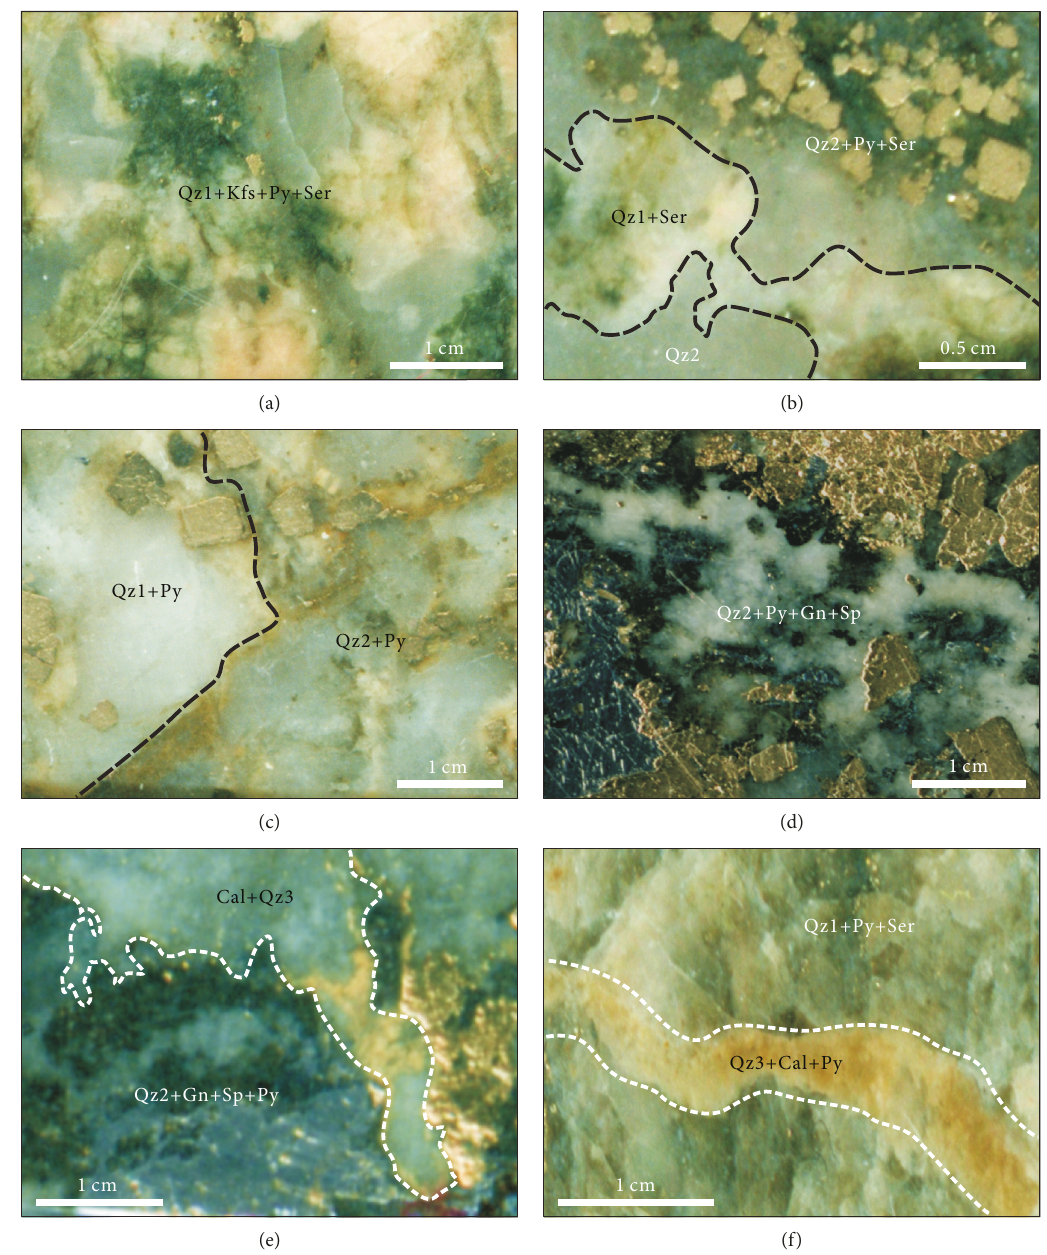
Figure 4: Photographs showing hand specimens and cross-cutting relationships of di ff erent veinlets of the Xiejiagou gold deposit. (a) Early- stage white quartz in K-feldspar pyrite sericite silica-altered rocks; (b) early-stage white quartz sericite K-feldspar assemblages cemented by middle-stage smoky gold quartz pyrite assemblages; (c) early-stage white quartz pyrite assemblages in fi lled by middle-stage smoky gold quartz pyrite assemblages; (d) middle-stage smoky gold polymetallic sul fi de quartz assemblages; (e) middle-stage smoky gold polymetallic sul fi de quartz assemblages cross-cut by late quartz carbonate pyrite veinlet; (f) pyrite sericite silica-altered rocks cross-cut by late quartz carbonate